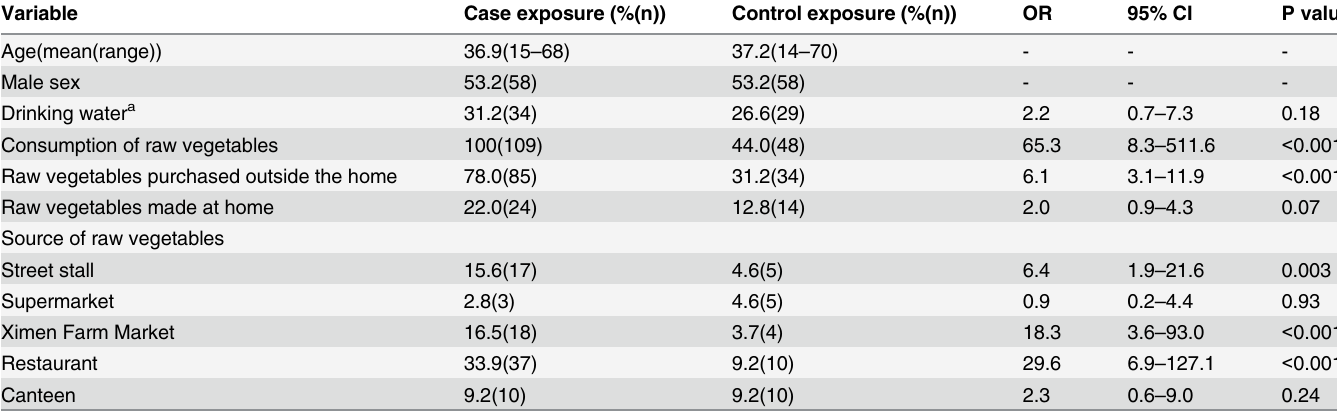
Table 1. Multivariable analysis of potential risk factors for 109 pairs of cases and age- and neighborhood-matched controls during paratyphoid fever outbreak.